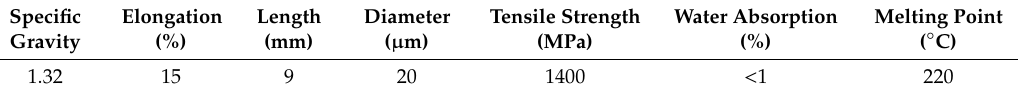
Table 2. Basic properties of polyvinyl alcohol (PVA) fiber.